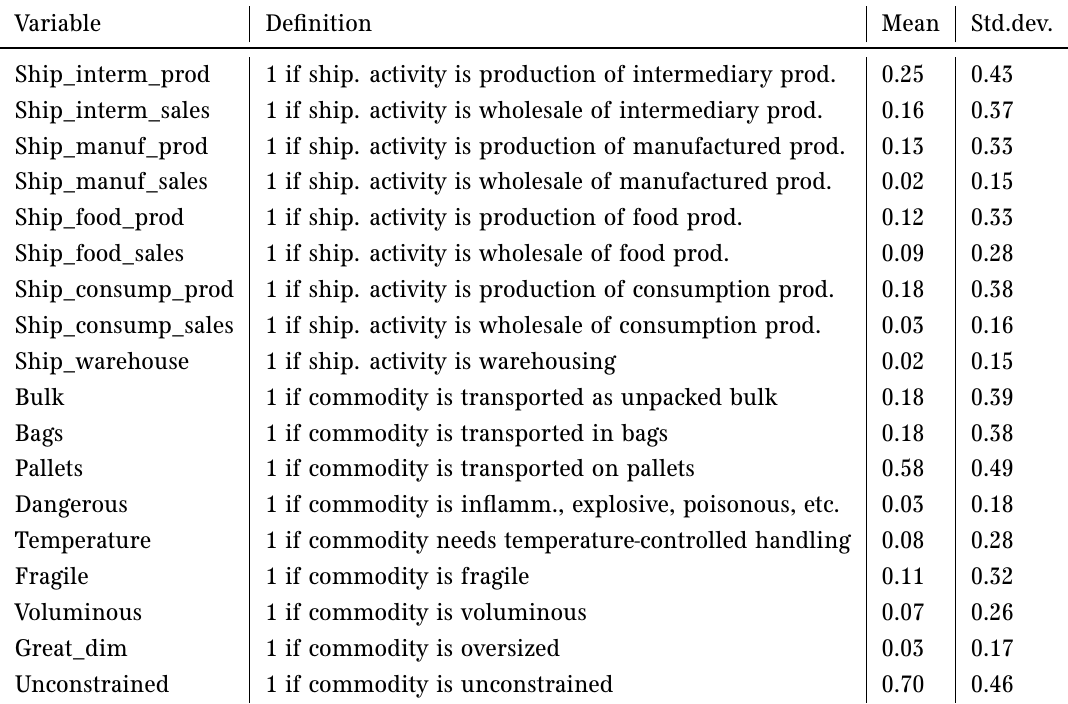
Table 2: Summary statistics of the LCA variables (2,219